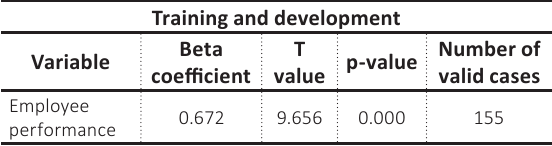
Table 4. Association between training